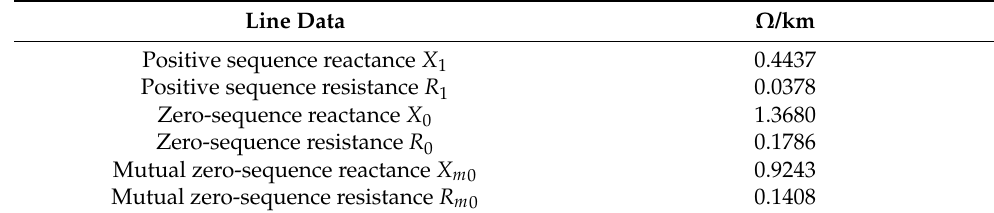
Figure 11. Schematic single-line diagram of a 220 kV transmission system. Table 1. Overhead line